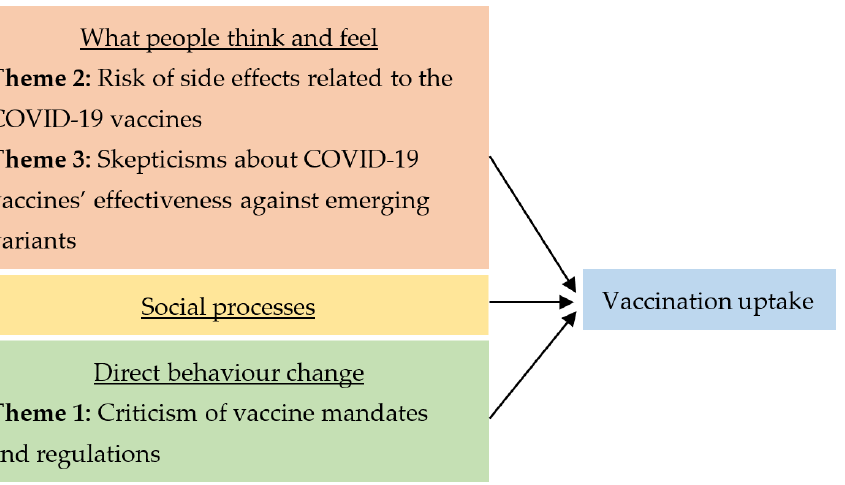
Figure 4. An illustration of how the themes fit into the increasing vaccination model [17].